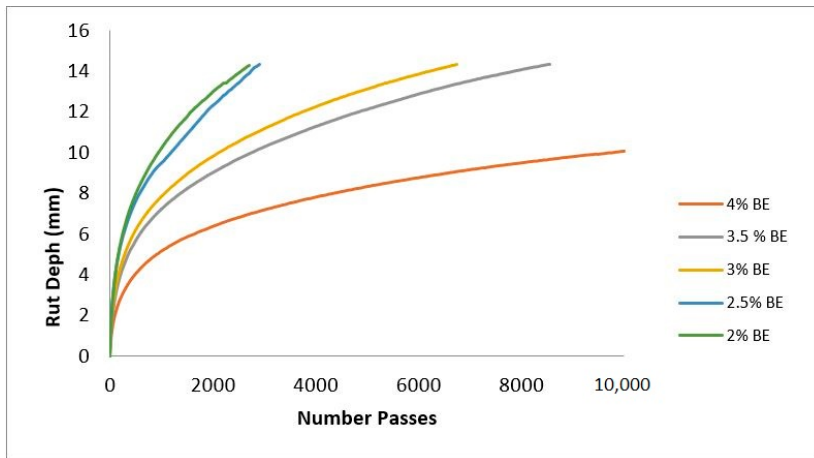
Figure 10. Wheel tracking results.